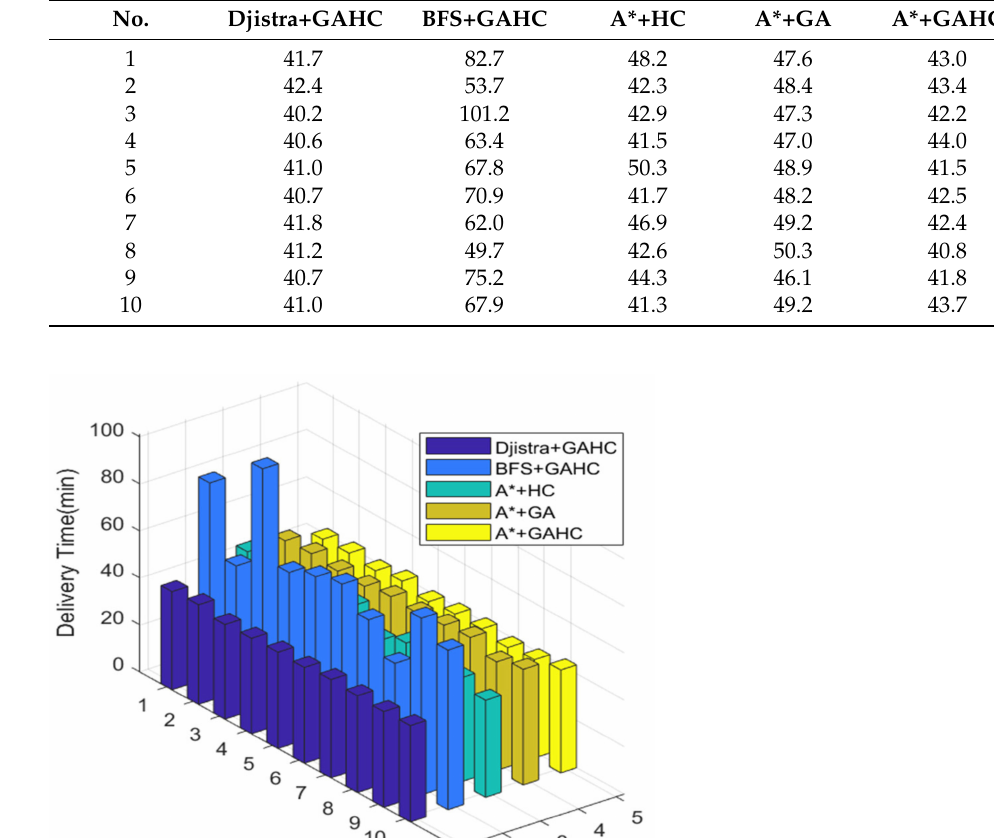
Table 5. Delivery time (minutes) in various algorithms.